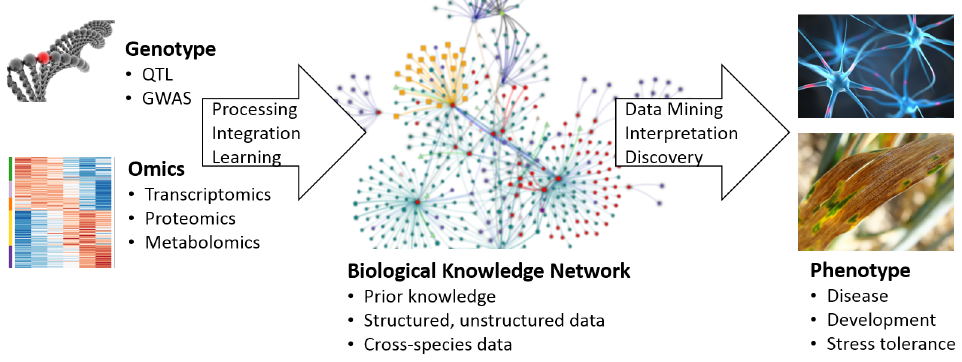
Figure 1: Using biological knowledge discovery to interpret genotype and omics experiments and establish links to phe- notypes and